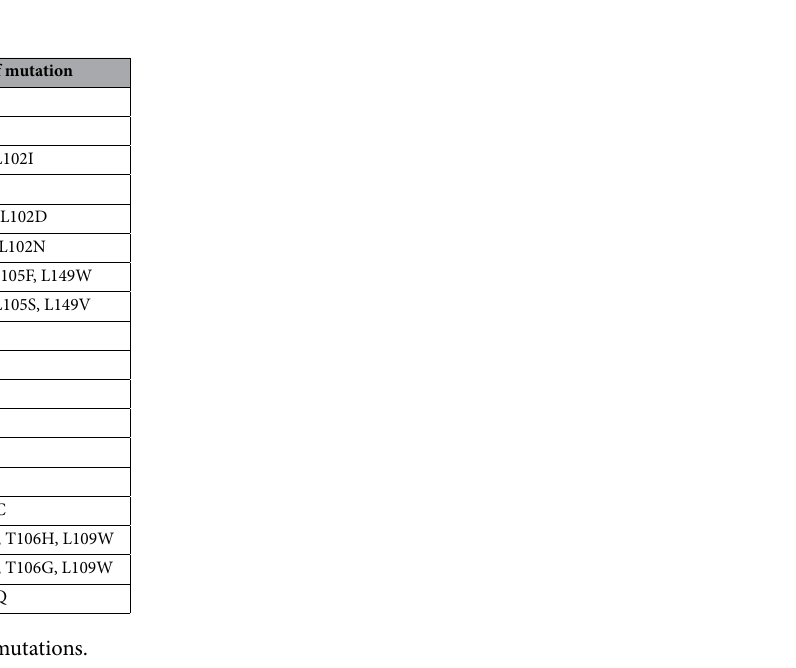
Figure 1. MHC epitope prediction analysis. ( a ) Shown is the amino acid sequence of EPO (residues 1–166). Sites contacted by the receptor (PDB: 1EER) are marked in red. Regions predicted by NetMHCII 2.2—a tool for HLA class II allele peptide prediction—for binding to HLA-DRB1*09-DQB1*03:09 to allele are highlighted in yellow. Sites recognized by neutralizing antibodies are underlined. Sites considered for amino acid modification are marked with an asterisk above. ( b ) Example of a network of interacting hydrophobic amino acids including two of allele binding sites, 74 and 102. Modification to 74 and/or 102 was then compensated with a suitable substitution at other positions in this network. The figure was generated using PyMOL version 2.3.4 (https :// pymol .org/2/).